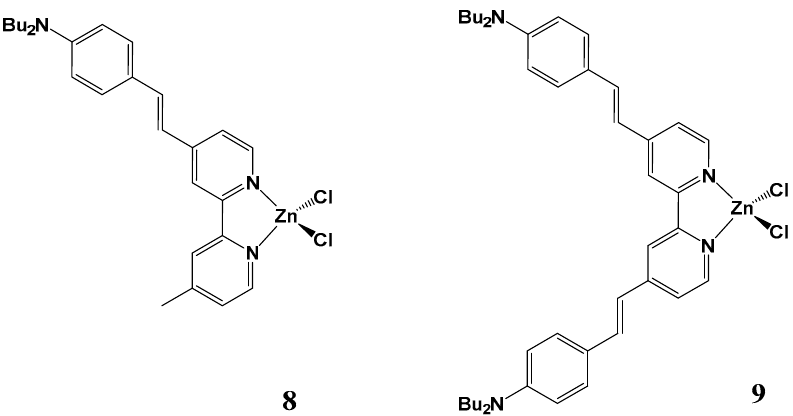
Figure 1. Second ‐ order nonlinear optical (NLO) ‐ active Zn(II) bipyridine complexes. Figure 1. Second-order nonlinear optical (NLO)-active Zn(II) bipyridine